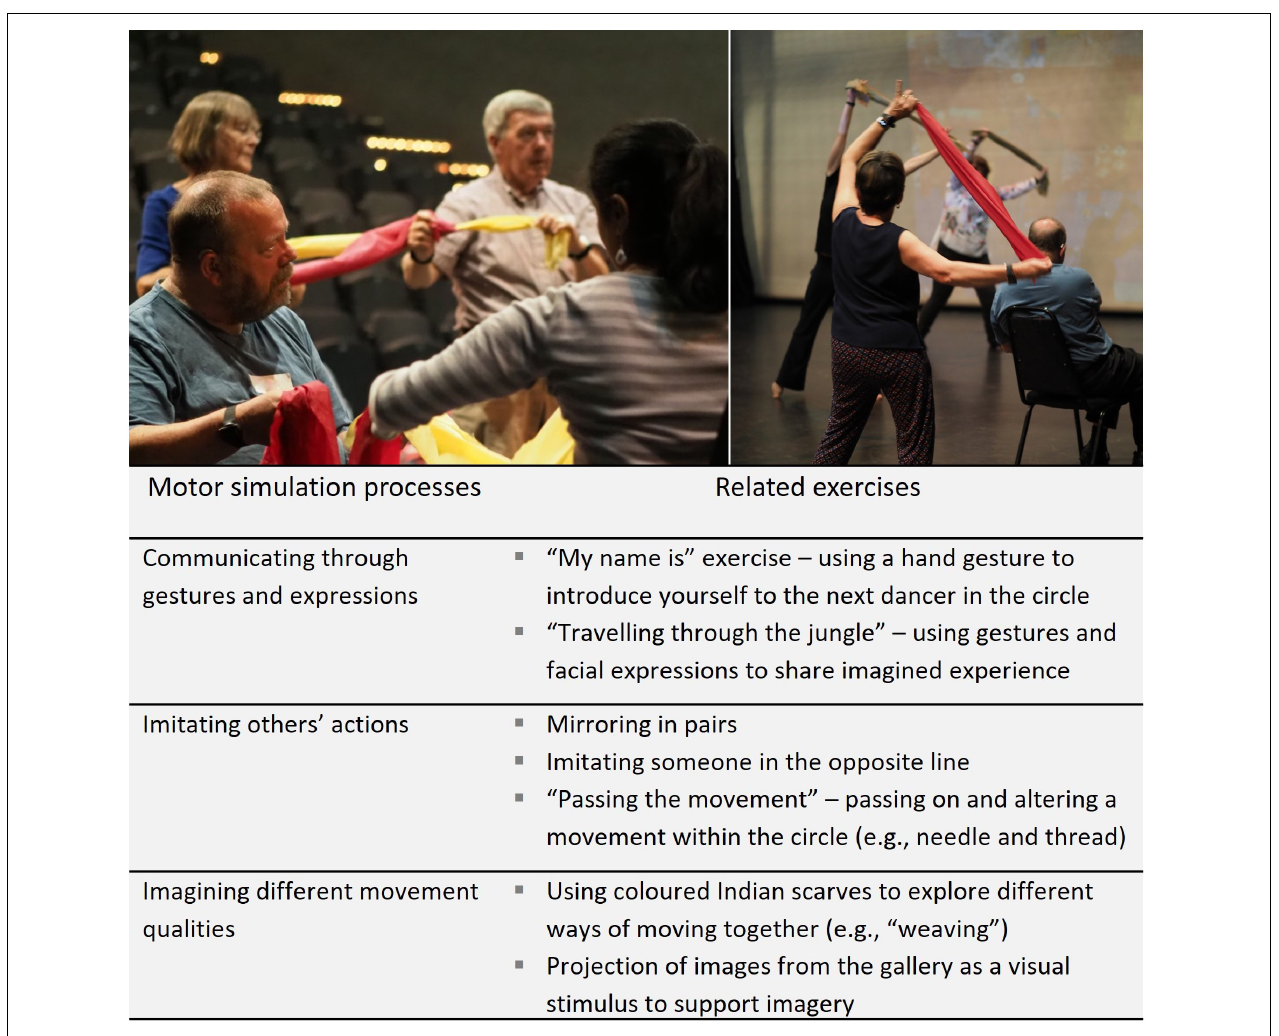
FIGURE 1 | Examples of how motor simulation was promoted within the dance classes by incorporating imagery and imitation into creative exercises (photography: Chris